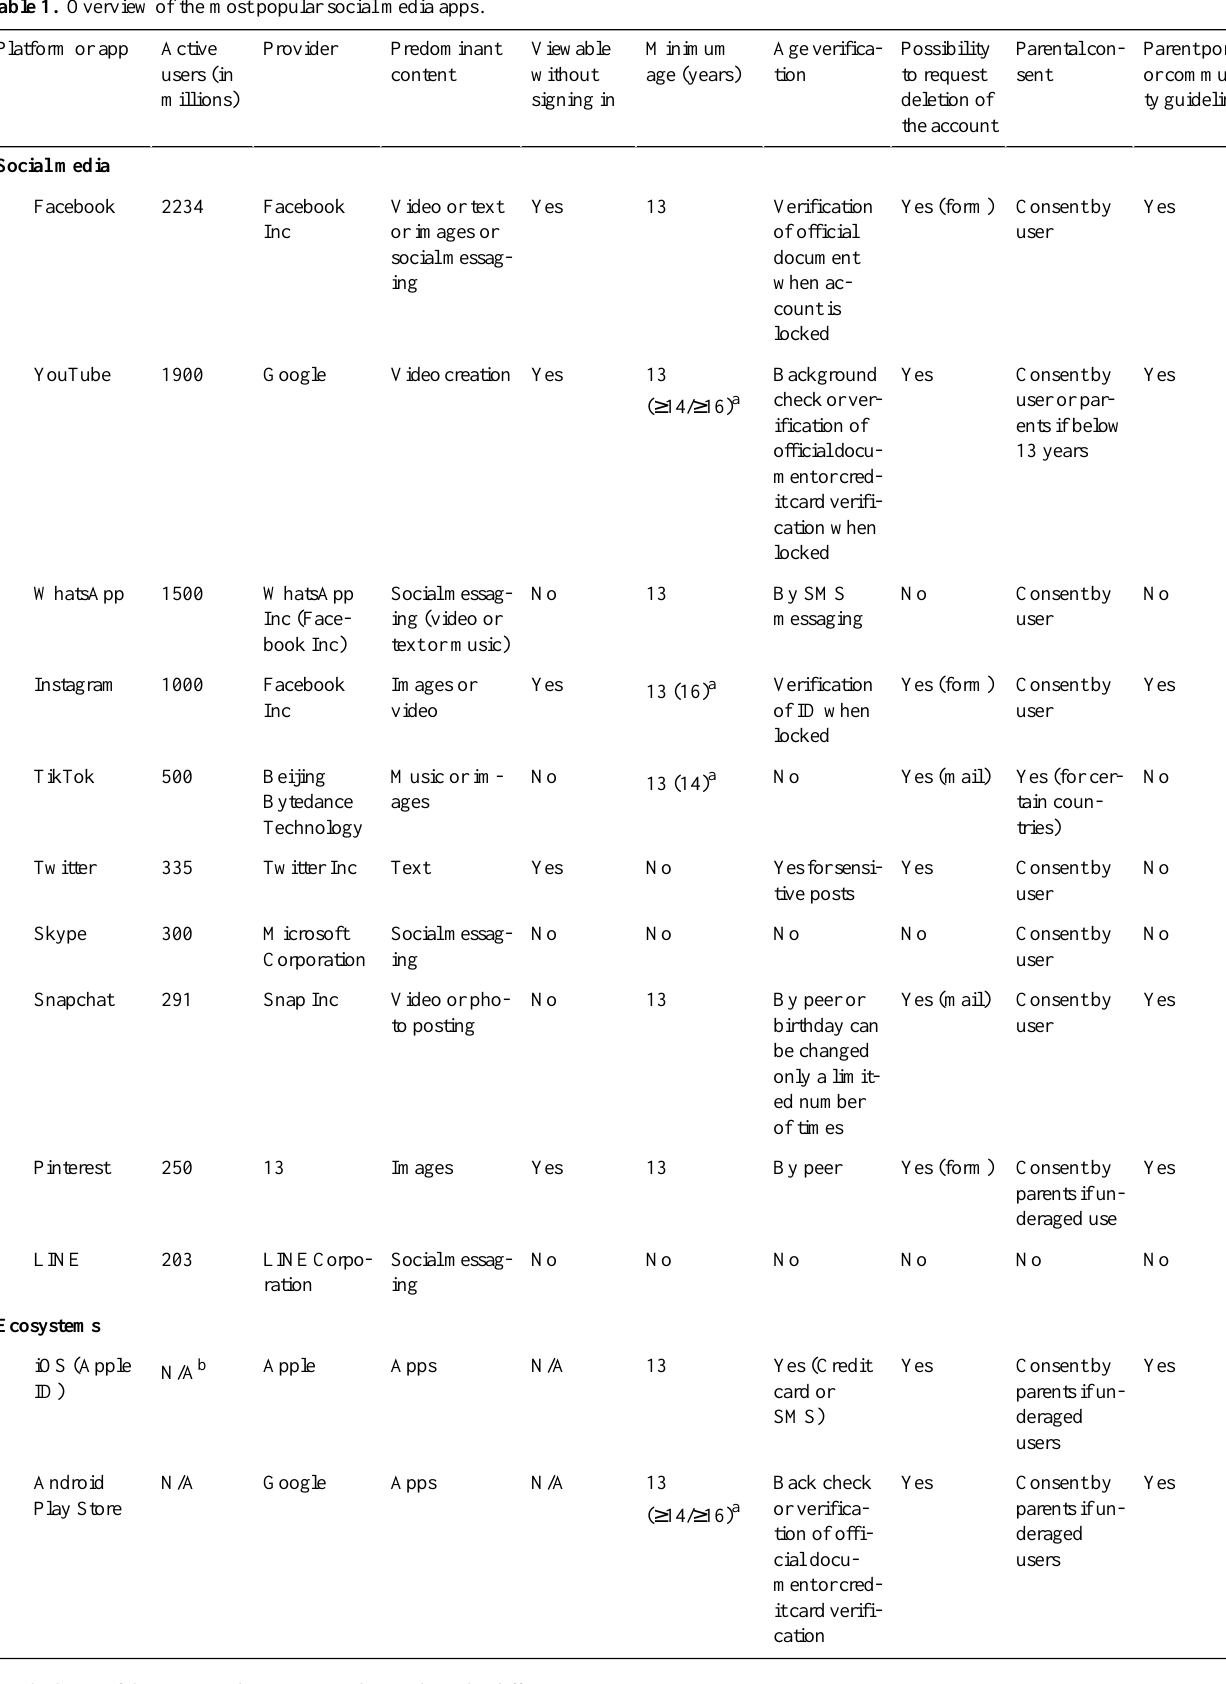
Table 1. Overview of the most popular social media